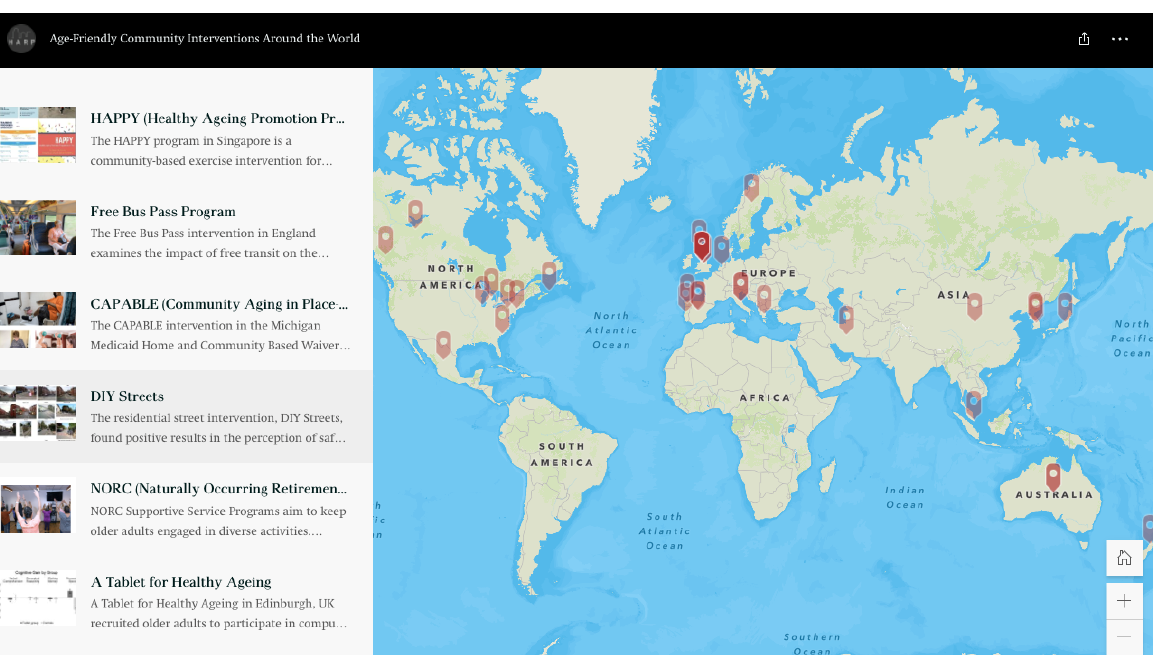
Figure A1. Interactive story map showing some of the key age-friendly community interventions around the world (https://www.harp.utah.edu/storymaps)( accessed on 2 January 2023) . Table A1. Search strings used in different bibliographic